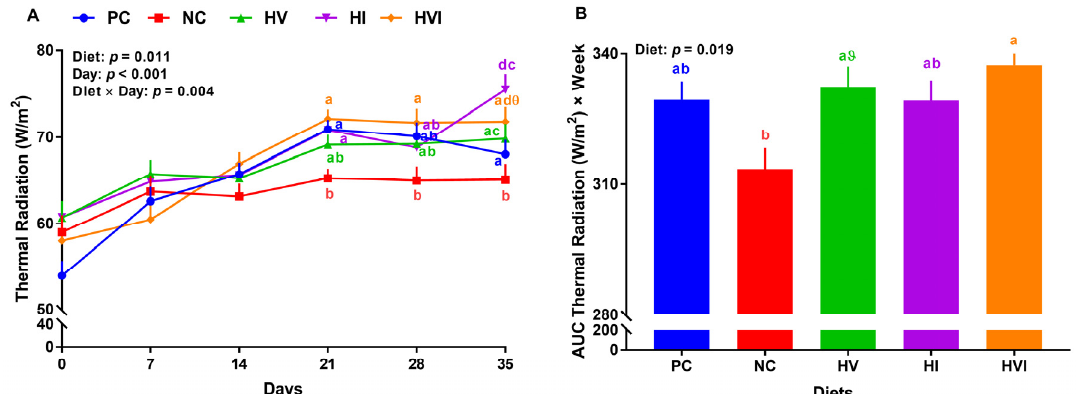
Figure 2. ( A ) Thermal radiation and ( B ) area under the curve (AUC) for thermal radiation in nursery pigs fed with very low protein diets containing isoleucine (Ile), valine (Val), or mix of both above NRC levels. PC: positive control, standard protein diet; NC: negative control, very low protein diet containing the first four limiting amino acids (i.e., lysine, methionine, threonine, and tryptophan) at NRC levels; HV: NC containing Val above NRC level; HI: NC containing Ile above NRC level; and HVI: NC containing both Val and Ile above NRC level. The values are means ± standard error of the mean. n = 8. a,b,ab Among groups, the means with different superscript letter(s) at each time point are different ( p ≤ 0.05). ϑ p ≤ 0.1 HV vs. NC, θ p ≤ 0.1 HVI vs. NC.